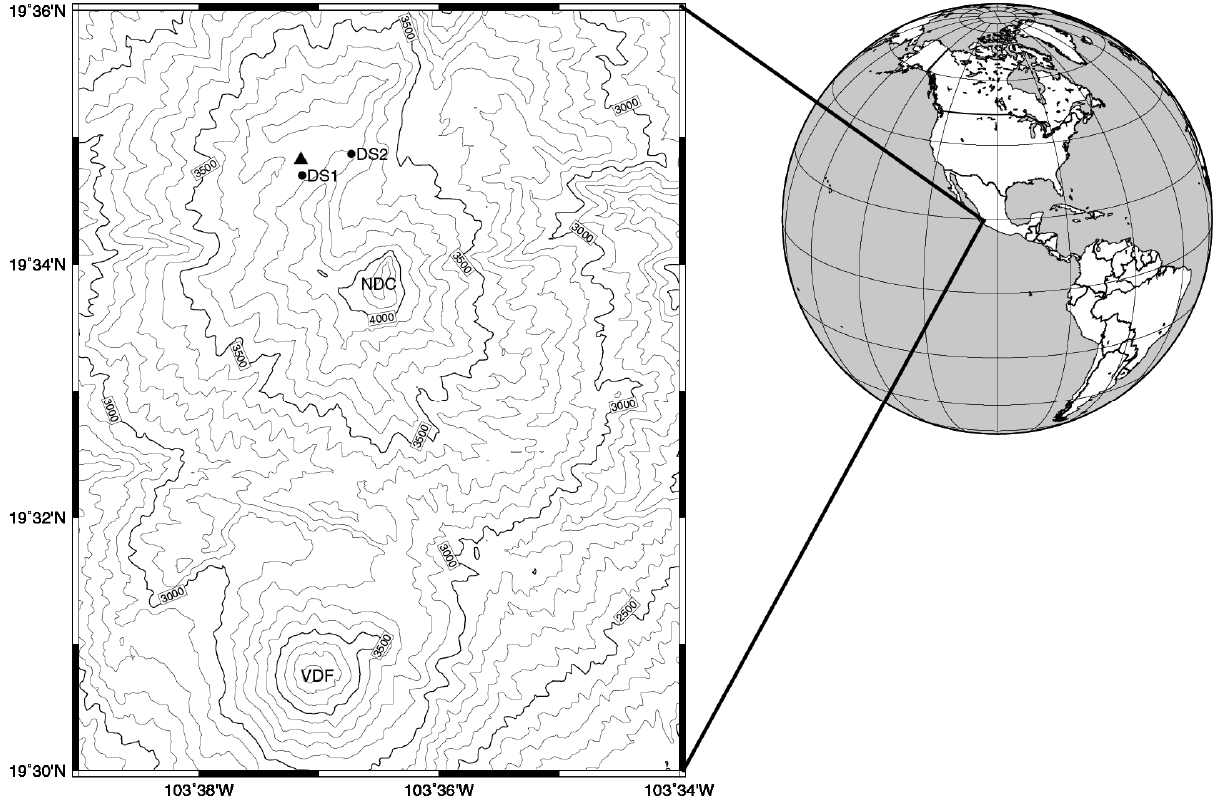
Figure 1. Global and topographic maps showing the location of the study area on Nevado de Colima (NDC), Mexico, in relation to the nearby Volcán de Fuego (VDF). Contour lines are drawn at 100 m intervals; the automated weather station ( ▲ ) and two dendrometer sites ( ● , DS1 and DS2) are about 300 m below treeline